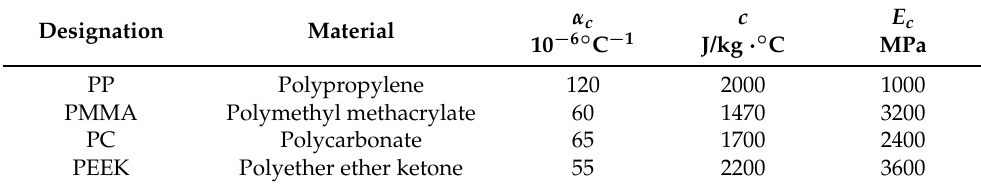
Figure 2. Scheme of the detector which consists of plastic-coated FBG. Table 2. Coating material of the four plastics used in the experiment, and their thermal expansion coefficient ( α c ) (from manufacturer), specific heat capacity ( c ) and Young’s modulus ( E c )